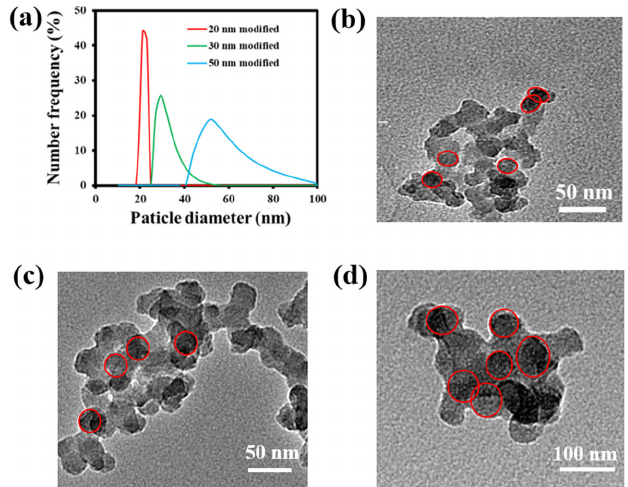
Figure 1. ( a ) DLS analysis of modi fi ed nanoparticles. ( b ) TEM images of 20 nm modi fi ed nanoparti- cles, ( c ) 30 nm modi fi ed nanoparticles, and ( d ) 50 nm modi fi ed nanoparticles. ( c ) 30 nm modified nanoparticles, and ( d ) 50 nm modified